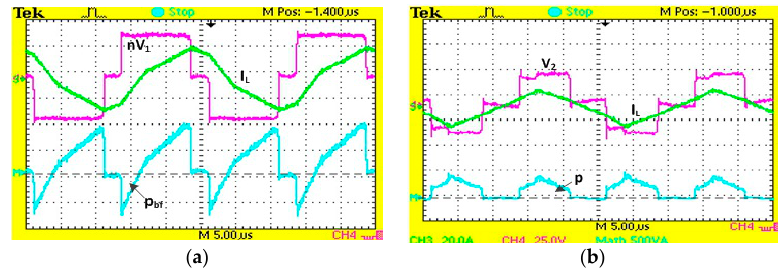
Figure 20. The waveform of transmission power in ( a ) Traditional control methods ( b ) The proposed methods.